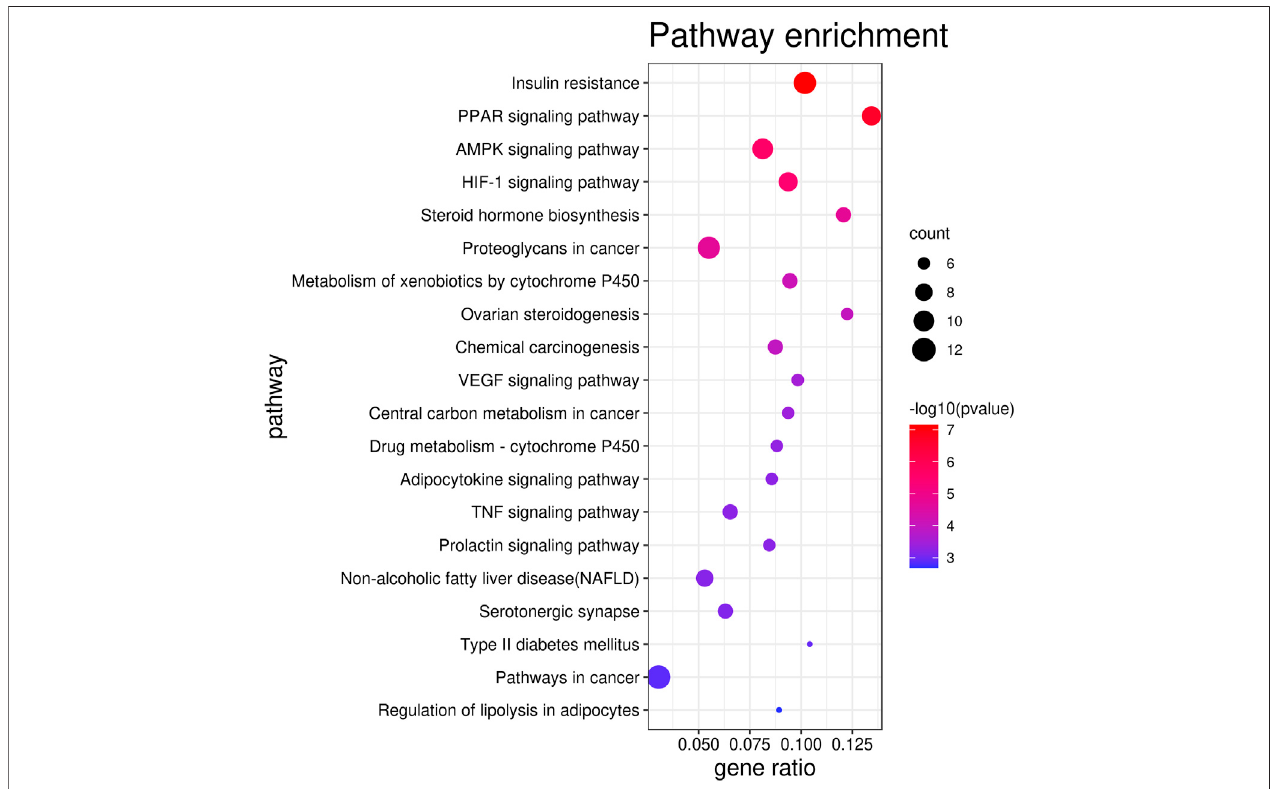
FIGURE 3 | Top 20 KEGG pathways selected based on the p